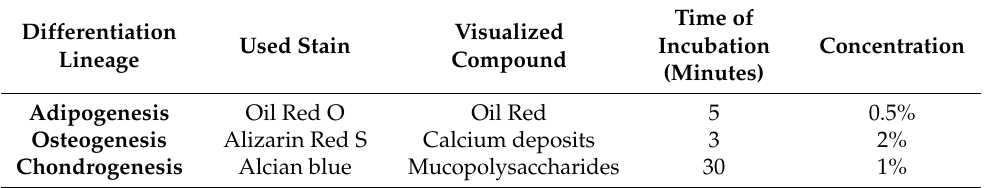
Table 1. Histochemical dyes (Sigma-Aldrich) used in differentiation analysis. Time of Visualized Differentiation Incubation Concentration Used Stain Compound Lineage (Minutes) Adipogenesis Oil Red O Oil Red 5 0.5% Osteogenesis Alizarin Red S Calcium deposits 3 2% Chondrogenesis Alcian blue Mucopolysaccharides 30